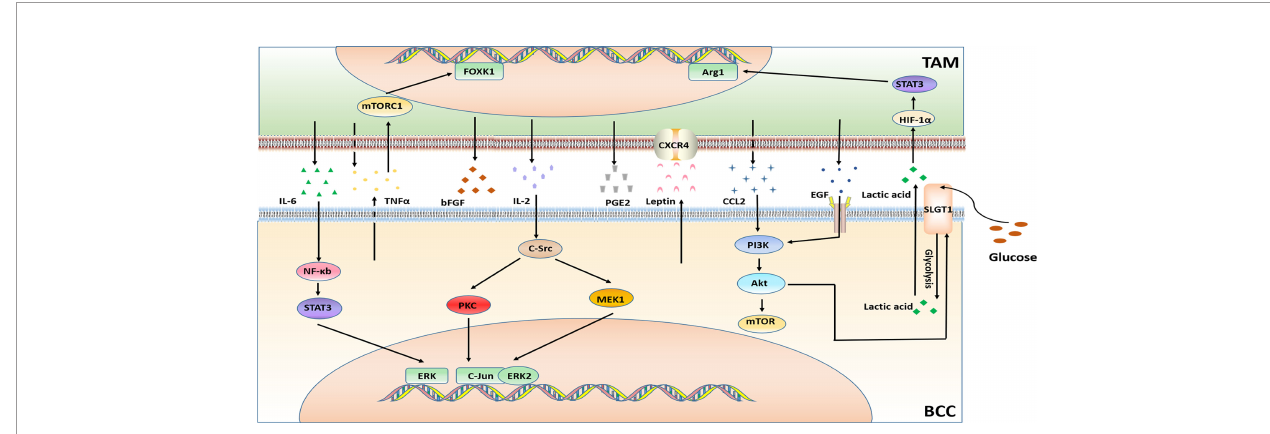
FIGURE 2 | Major mechanisms of endocrine therapy resistance in BC in connection with